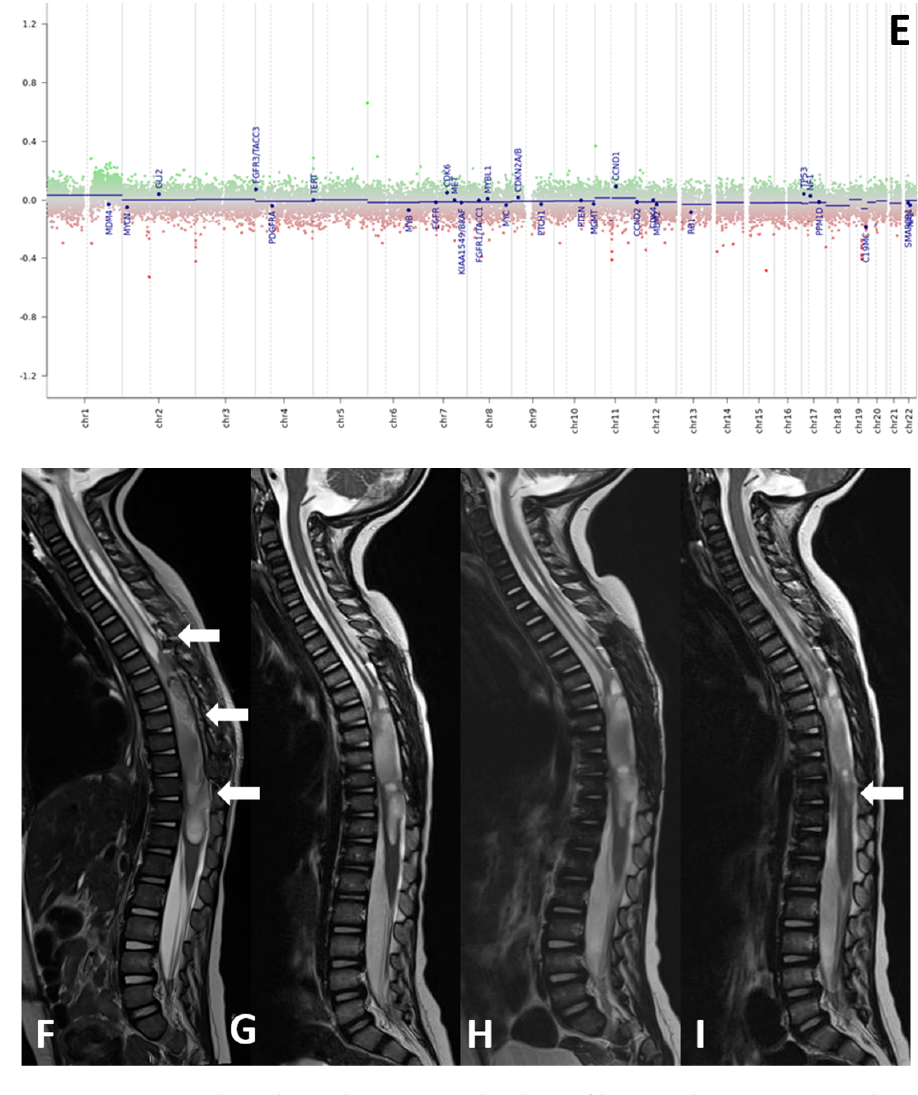
Figure 1. ( A – I ) Histological samples ( A – D ), molecular profile ( E ), and MRI imaging at diagnosis ( F ), after standard chemotherapy regimens ( G ) and at three months ( H ) and six months ( I ) after the start of larotrectnib in patient number 7. The tumor consisted of small spindle cells embedded in a myxoid background ( A ). Mitoses were present throughout. The tumor showed foci of necrosis ( B ) and microvascular proliferation. OLIG2 was diffusely expressed ( C ); GFAP expression was multifocal ( D ). Molecular profiling with classifier v11.b4 did not reveal any match. Revaluation with classifier v12.3 showed GBM pedRTK1a glioblastoma, pediatric RTK1 type, subtype A (score 0.31337). At imaging evaluation, the neoplasm is characterized by solid-cystic aspect. Sagittal T2-weighted sequences at four consecutive time points: post first surgery approach (arrows, ( F )), after induction chemotherapy ( G ), after three months ( H ) and after six months after the start of larotrectnib ( I ). At the last follow-up, there was a moderate reduction in the size of the neoplasm, especially in the solid caudal portions (arrow, ( I )).